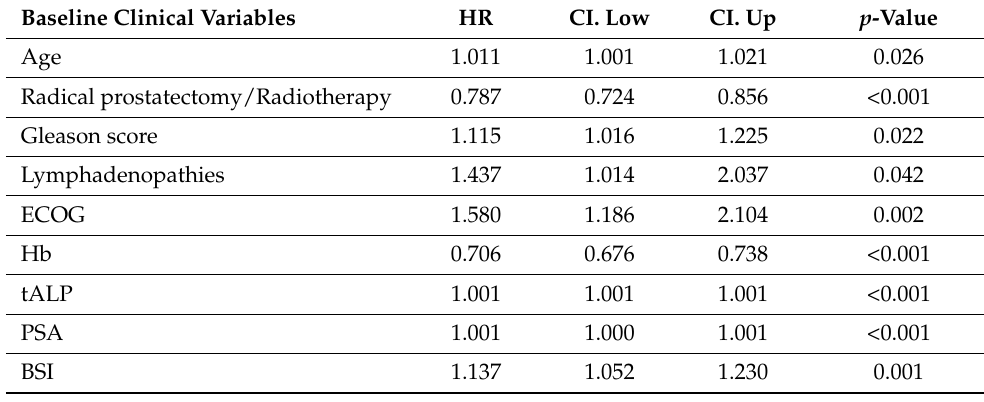
Table 2. Center-adjusted univariate—cox regression analysis of overall survival (OS) in relation to baseline variables.